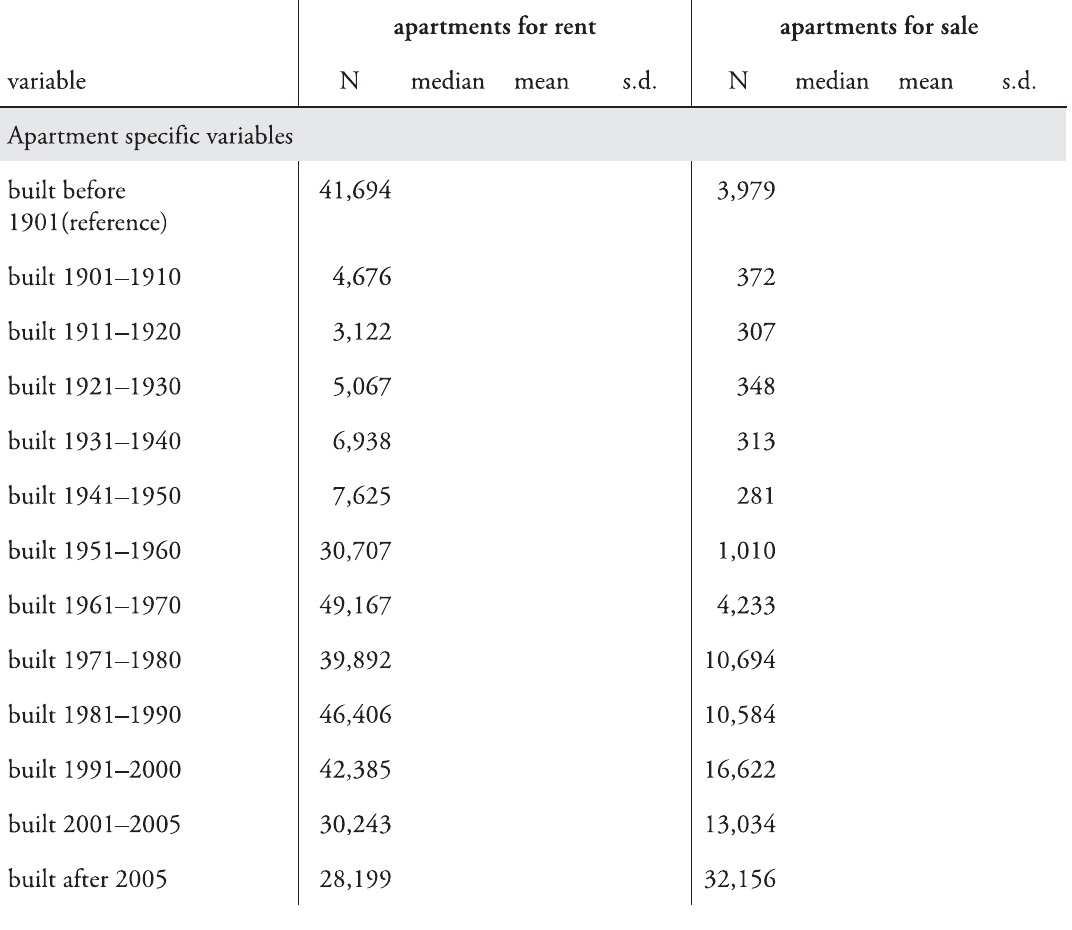
Table 1: Summary